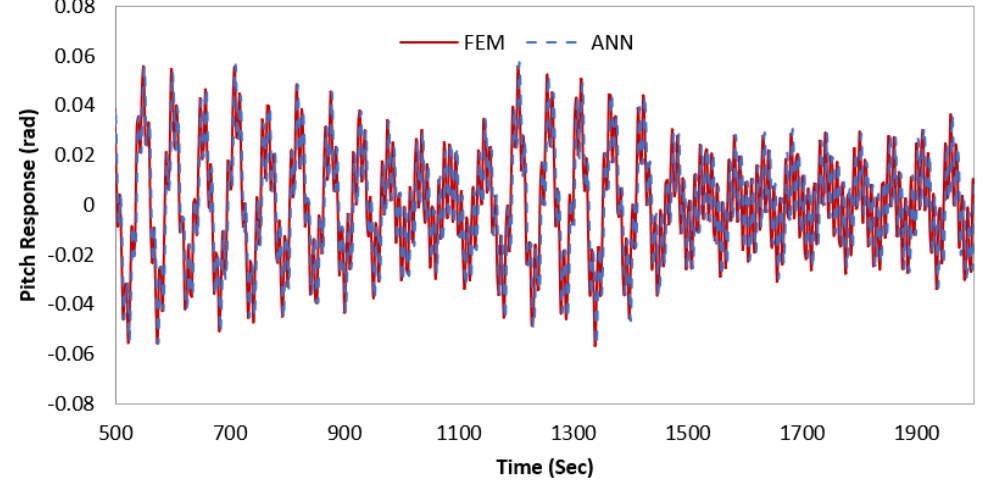
Figure 10. The pitch response time history predicted by the training data of ANN and FEM results for wave height of 9.65 m) and the wave period of 9.94 s.